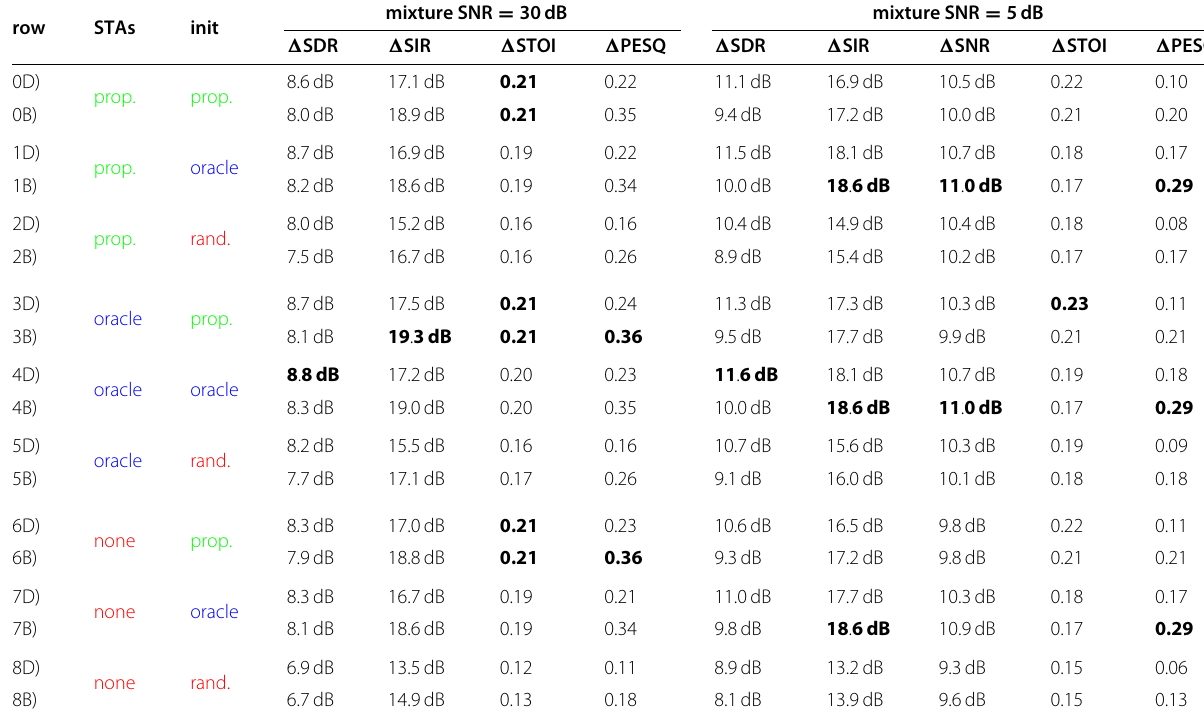
Table 2 Results with oracle DOAs for low-noise (left) and noisy (right) conditions. Each row corresponds to a fixed combination of STAs (Eq. 31), initialization (proposed DOA-based (Eq. 19), oracle (Eq. 34), or random), and mask application (“D” for direct (Eq. 7), “B” for beamforming (Eq. 12)). The rows are numbered from 0 to 8 for ease of reference. Boldface is used to indicate the highest scores for each metric. We note that the STAs are helpful on their own, but not needed if the proposed initialization is used. The difference between the results for proposed and oracle initialization is mainly due to the respective behavior at low frequencies